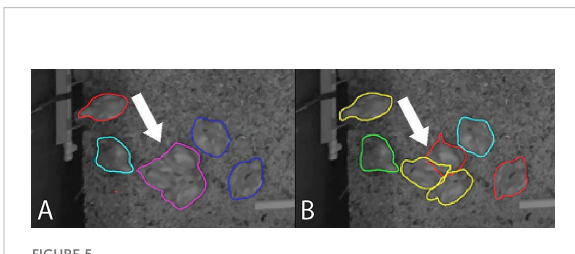
FIGURE 5 Comparison of segmentation results for the research facility using (A) U-Net or (B) Mask R-CNN approach. The purple segmentation in (A) shows a cluster of three broilers that were wrongly annotated as a single broiler.